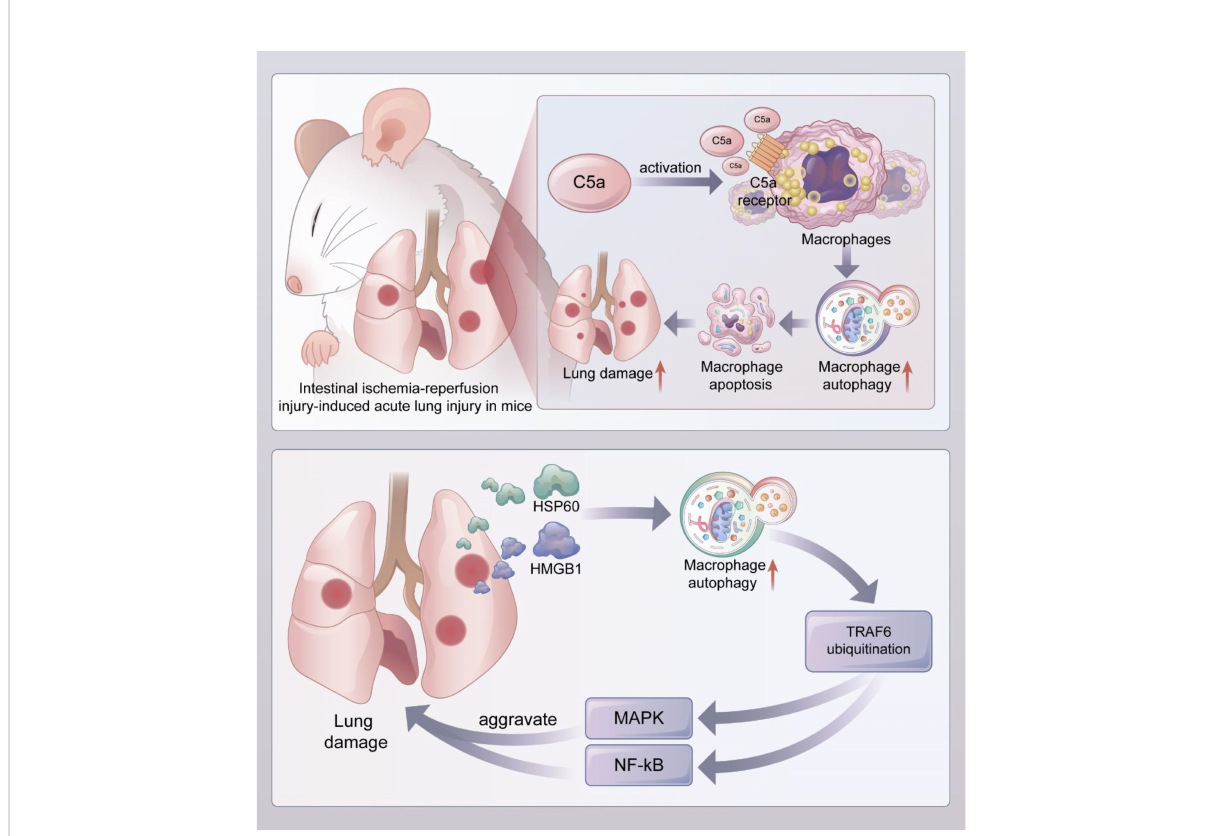
FIGURE 4 Macrophage autophagy aggravates lung injury ( 1 ). In the mouse model of acute lung injury induced by intestial ischemia-referfusion injury, complement C5a activated alveolar macrophages and bound to C5a receptors on their surface, leading to enhanced autophagy and induced apoptosis of alveolar macrophages, which exacerbated lung injury (2). DAMPs such as HMGB1 and HSP60 released during acute lung injury promoted uniquitination of TRAF6 by inducing autophagy of alveolar macrophages, and activated downstream MAPK and NF-kB signaling pathways to aggravate lung injury. DAMPs, Damaged-associated molecular patterns; HMGB1, High mobility group protein box 1; HSP60, heat- shock protein 60; TRAF6, TNF receptor associated factor